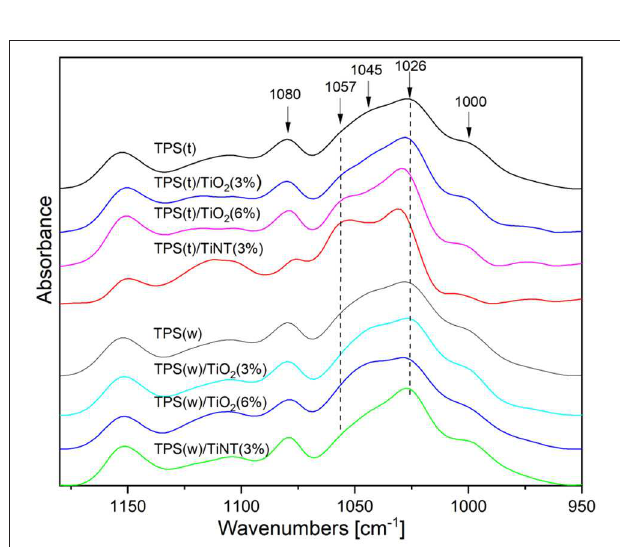
FIGURE 5 | IR spectra of plasticized tapioca and wheat starch and difference spectra of the TPS/TiX composites. From the spectra of all TPS/TiX composites, the spectra of the corresponding pure plasticized starches [TPS(t) or TPS(w)] were partially subtracted in order to emphasize difference peaks, as described in section XRD and IR